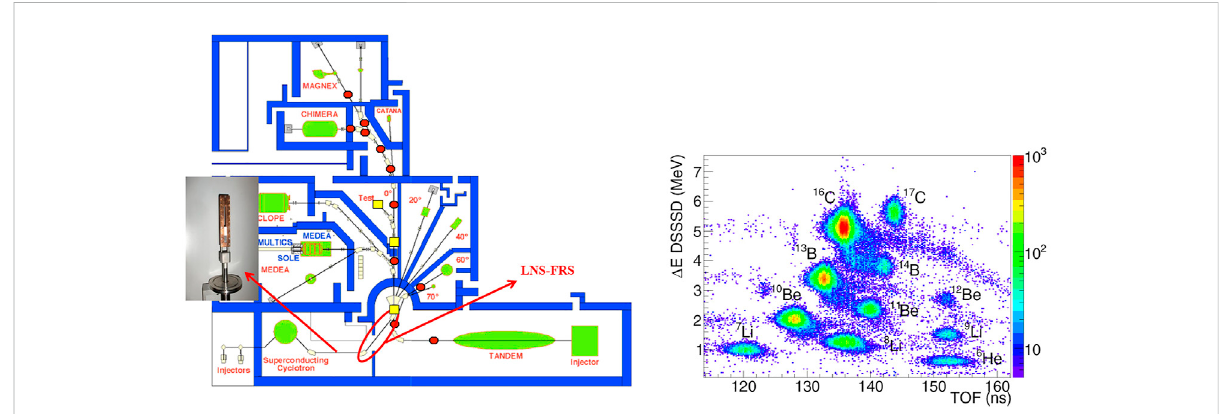
FIGURE 1 Left: map of the INFN-LNS before the upgrading project. The fragment separator is located inside the red ellipse. The photo in the inset shows the beryllium target system. Dots indicate diagnostics elements made of plastic scintillators, while squares indicate diagnostics elements based on double-sided siliconstripdetectors, fi gure adapted from[33].Right: Δ E-TOFcorrelation plotobtained withthetaggingsystem usedintheCHIMERA beamline, for a cocktail beam produced by 18 O beam of 55 AMeV on a 1500 μ m thick 9 Be target, fi gure adapted from